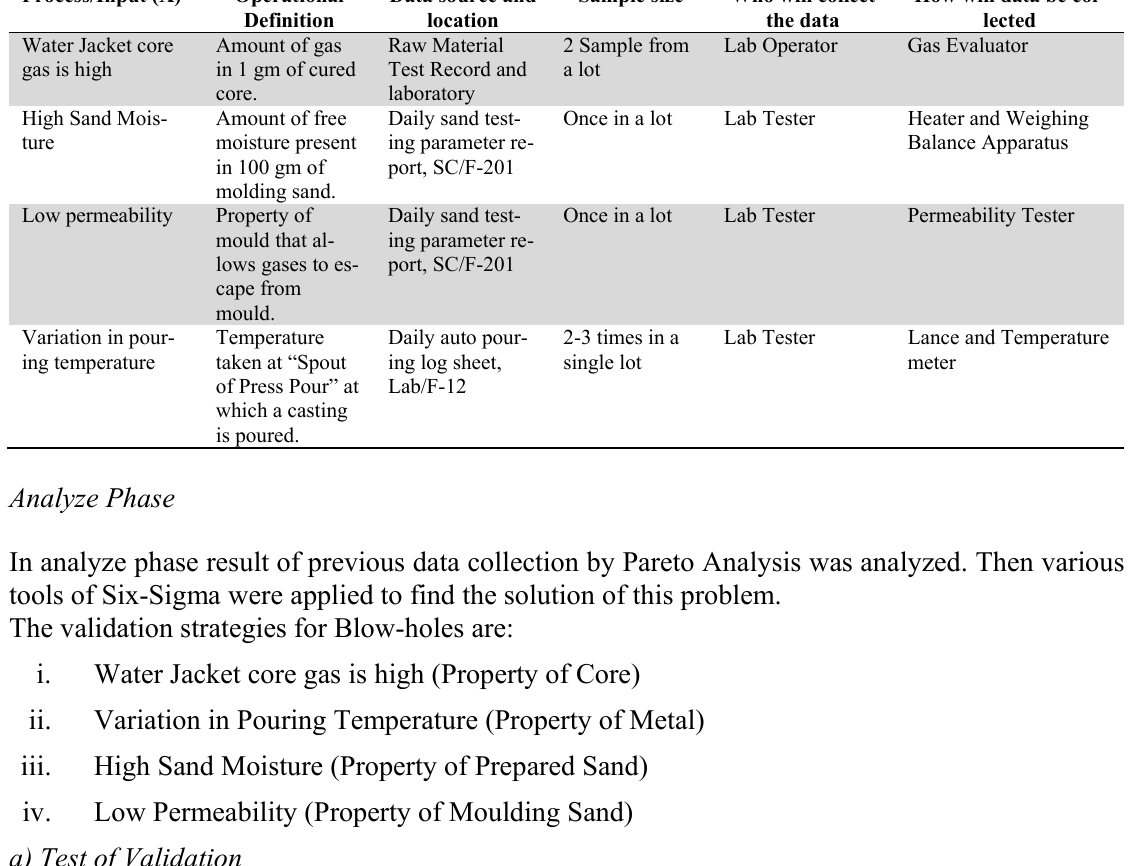
Fig. 8. Anderson – Darling Normality Test for Pouring